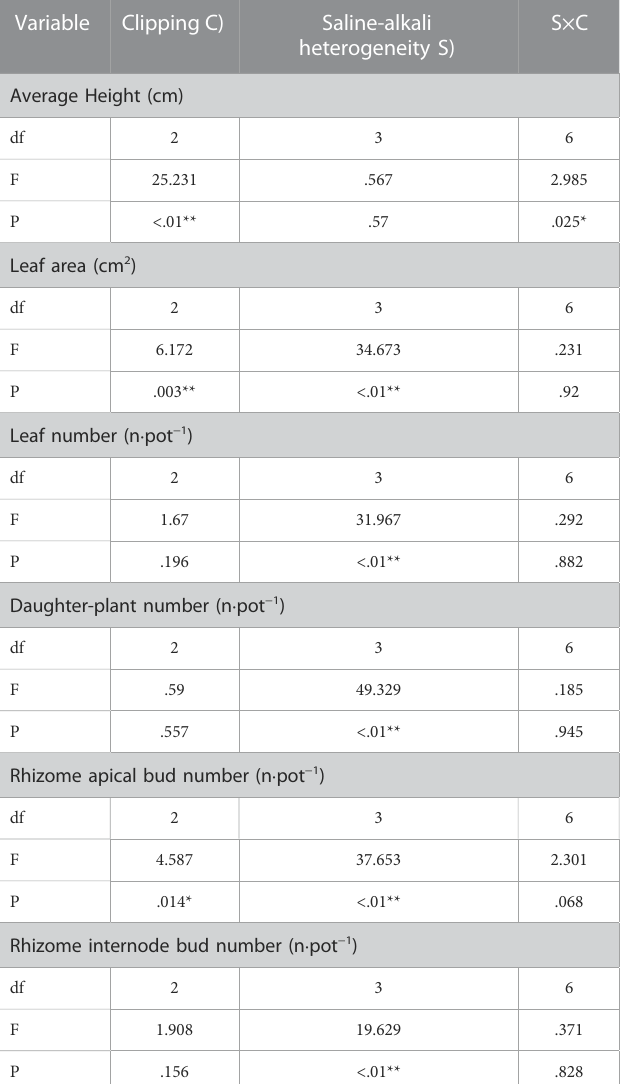
TABLE 2 Statistical summary of two-way ANOVA evaluating the effects of saline- alkali heterogeneity of soil and clipping their combined effects on the average height (AH), leaf area (LA), leaf number (LN), Daughter-plant number (DN), Rhizome apical bud number (RABN) and rhizome internode bud number (RIBN) of L. chinensis . Values are F ratios and their signi fi cance for effects. F values and signi fi cance levels (**, p < .01; *, p < .05) are given.